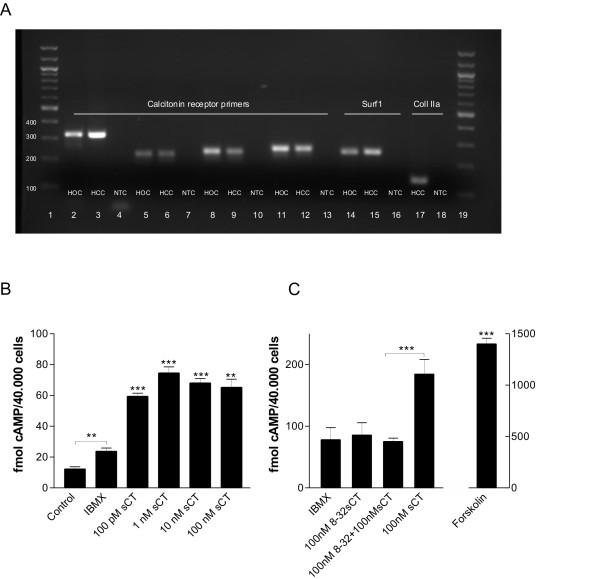
Human chondrocytes express the calcitonin receptor. A. Calcitonin receptor expression in human osteoclasts and cartilage was analyzed using QPCR. QPCR products were visualized on a 2% agarose gel. Lanes: 1+19 NEB 100 bp DNA ladder, 2-4 CalcR1, 5-7 CalcR2, 8-10 CalcR 3, 11-13 CalcR 4, 14-16 Surf 1, 17-18 Coll2a. Abbreviations: CalcR - calcitonin receptor primer pair 1-4; Coll2a - Collagen type II; HOC - human osteoclasts; HCC - human chondrocytes; NTC - no template control. B. Intracellular cAMP levels after stimulation with salmon calcitonin: Human OA chondrocytes were stimulated with IBMX for one hour, followed by 15 minutes stimulation in presence or absence of salmon calcitonin as specified in the figure legends. C. Binding competition by the calcitonin receptor antagonist 8-32sCT. Forskolin was used as positive control. The asterisks indicate significant differences (** P < 0.01, *** P < 0.001).